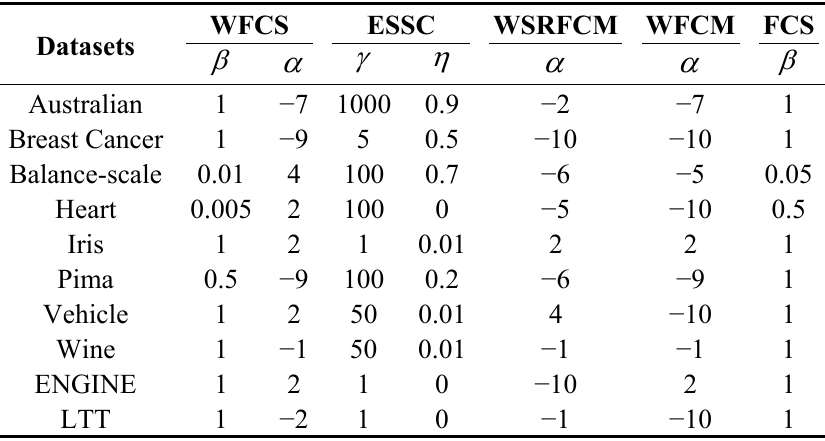
Table 3. Parameter values for 10